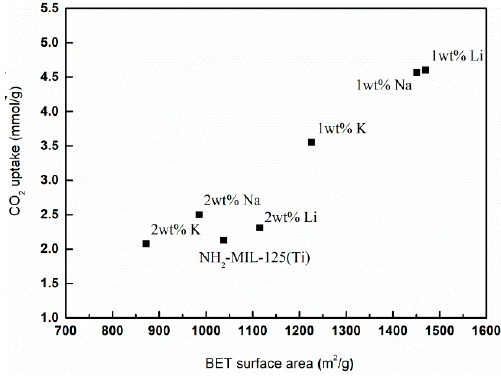
Figure 9. The relationship of CO 2 uptake on x M@NH 2 –MIL125(Ti) with S BET at 293 K and 1 atm.